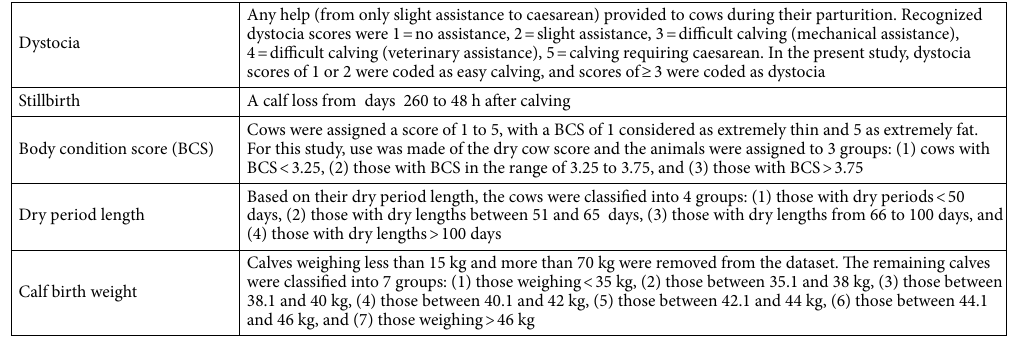
Table 2. The definitions of the traits used in the study.